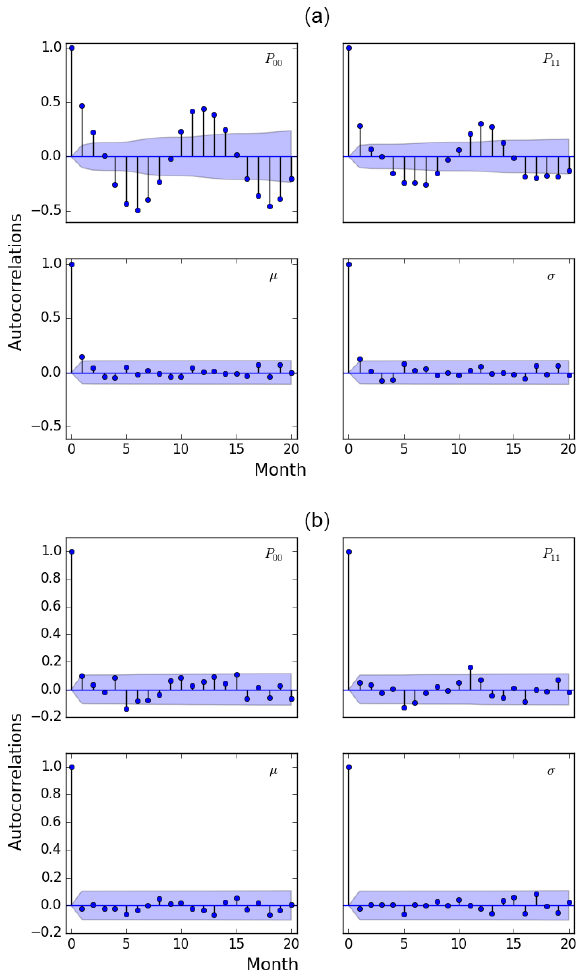
Figure 5. Month-to-month autocorrelations of P 00 , P 11 , µ , and σ for (a) Adelaide and (b) Sydney. The shadings indicate 95% confi- dence